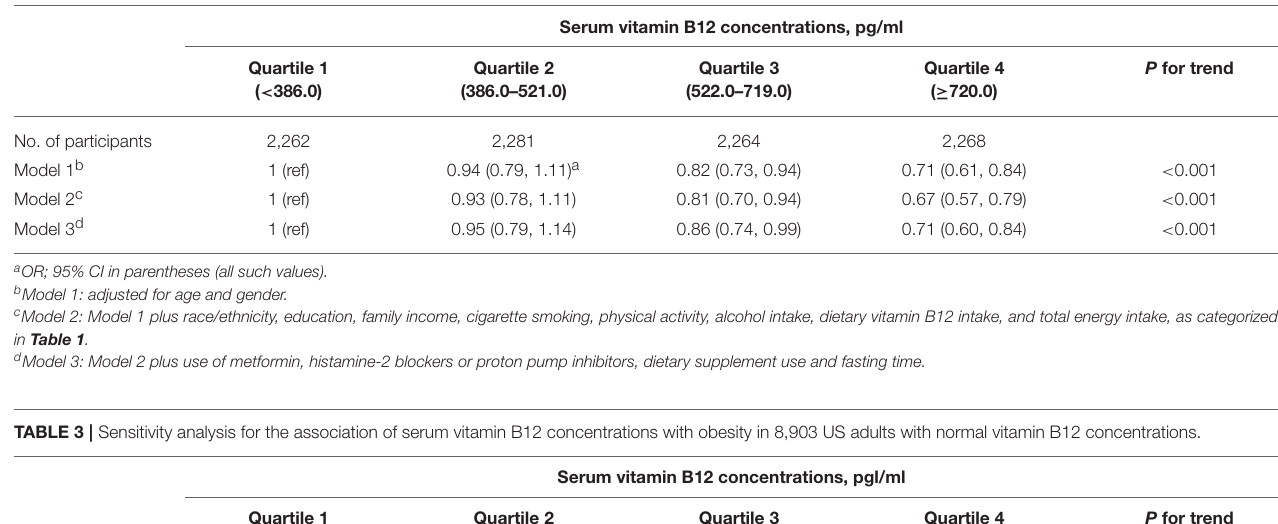
TABLE 2 | Associations of serum vitamin B12 concentrations with obesity in 9,075 US adults. Quartile 1 ( < 386.0)